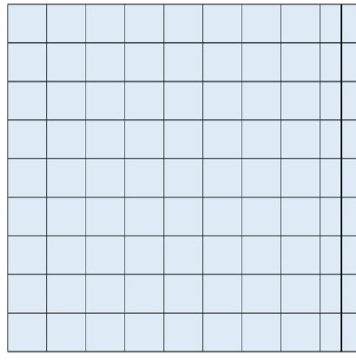
Fig. 7 Finite element mesh used in the analysis and unfitted boundary